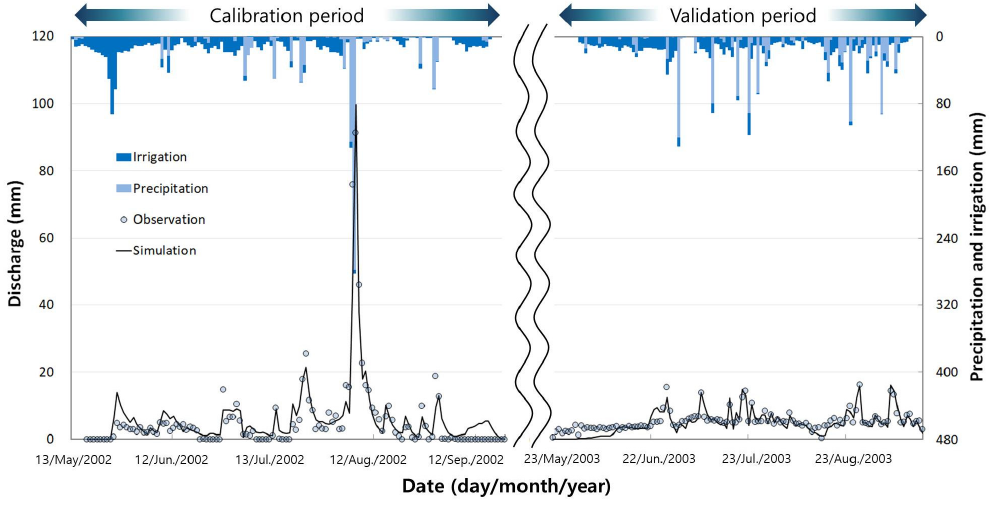
Figure 4. Predicted daily paddy field discharges are calibrated for the growing season in 2002, and then validated for the year 2003 at the Icheon site.